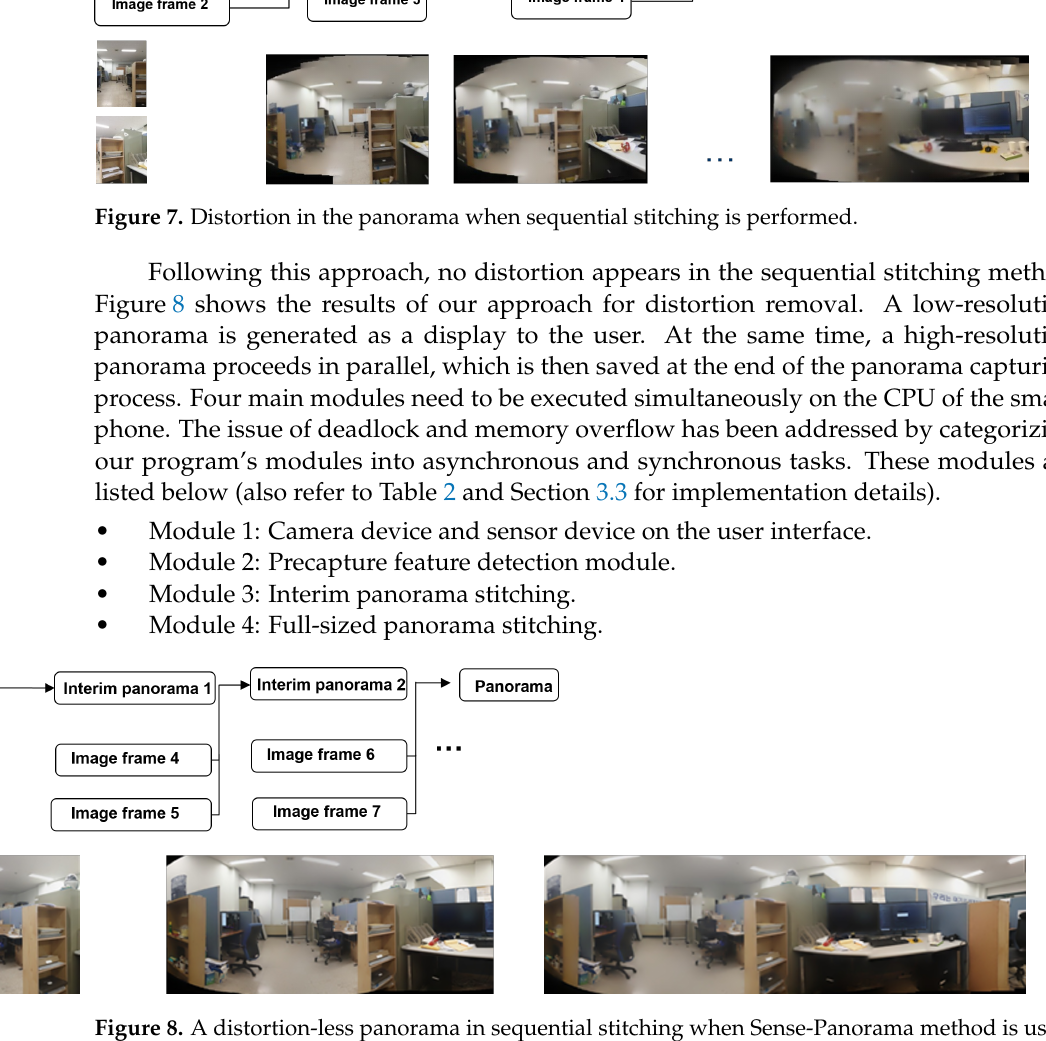
Figure 8. A distortion-less panorama in sequential stitching when Sense-Panorama method is used. The first module (module 1) executes the camera device and sensor device on the user interface thread synchronously with each other; the camera module captures frames; and the sensor module triggers events, controls camera capture events, and moderates the stitch- ing process. The remaining three modules in the above list are executed asynchronously, and their results are returned to the main thread when they are